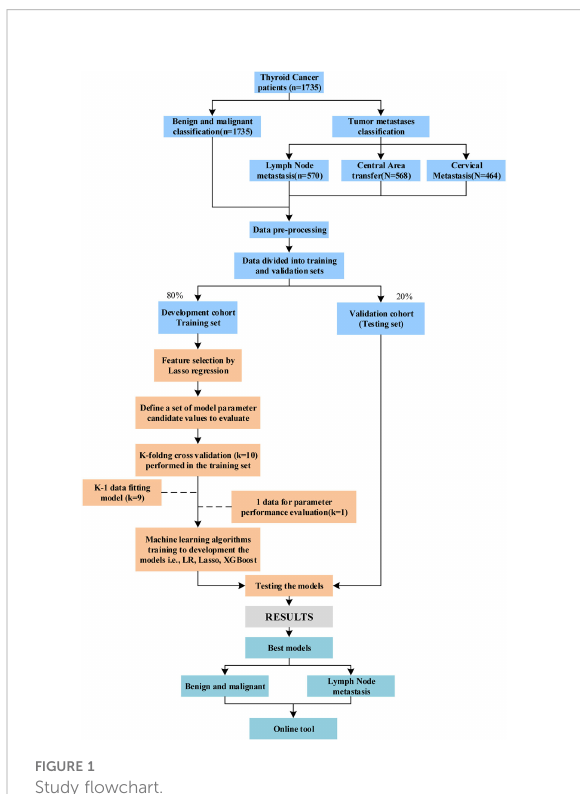
FIGURE 1 Study fl